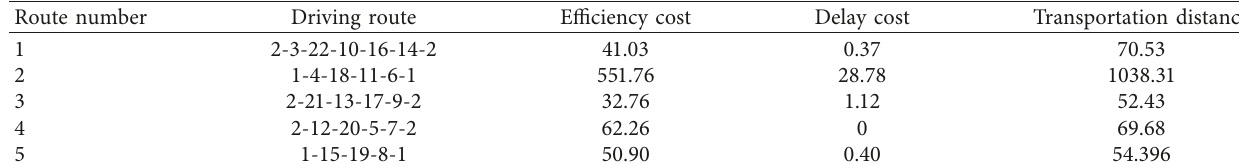
Table 5: Subpath transport route on the repairing number 2.